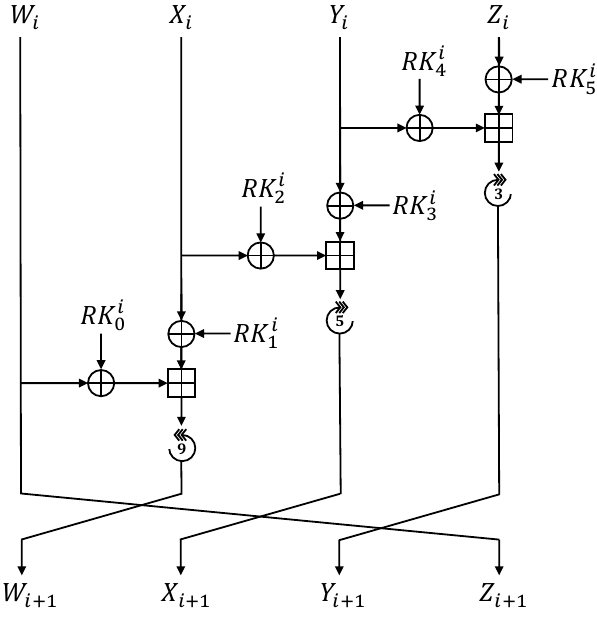
Figure 2. Round function of Lightweight Encryption Algorithm